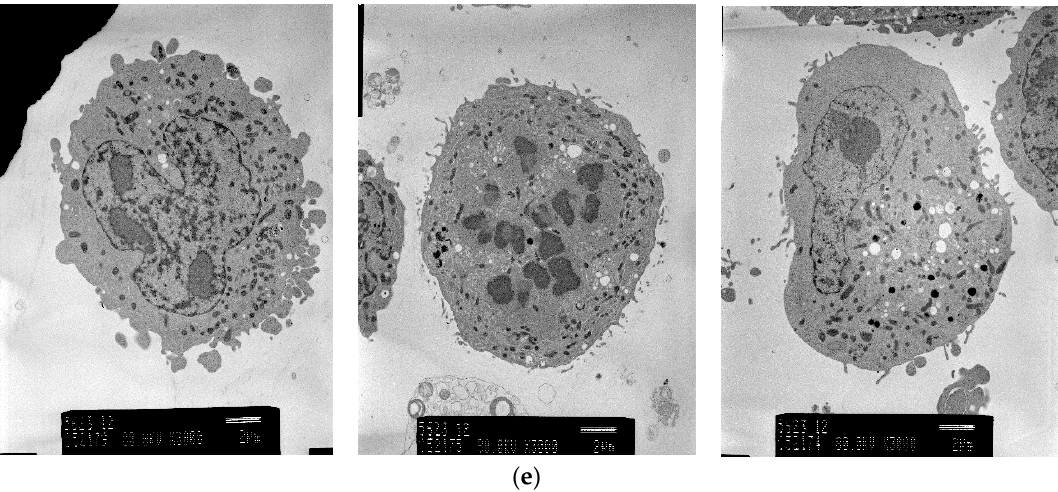
Figure 4. Electron micrographs (3000×) of pigment cells treated with 4HP (125 µmol/L), RK (125 µmol/L), ML (25 µmol/L), or 4BR (50 µmol/L). 4HP, rhododendrol; RK, raspberry ketone; ML, magnolignan; ARB, arbutin; 4BR, 4-n-butylresorcinol: ( a ) Control; ( b ) 4HP (125 µmol/L); ( c ) RK (125 µmol/L); ( d ) ML (25 µmol/L); ( e ) 4BR (50 µmol/L).